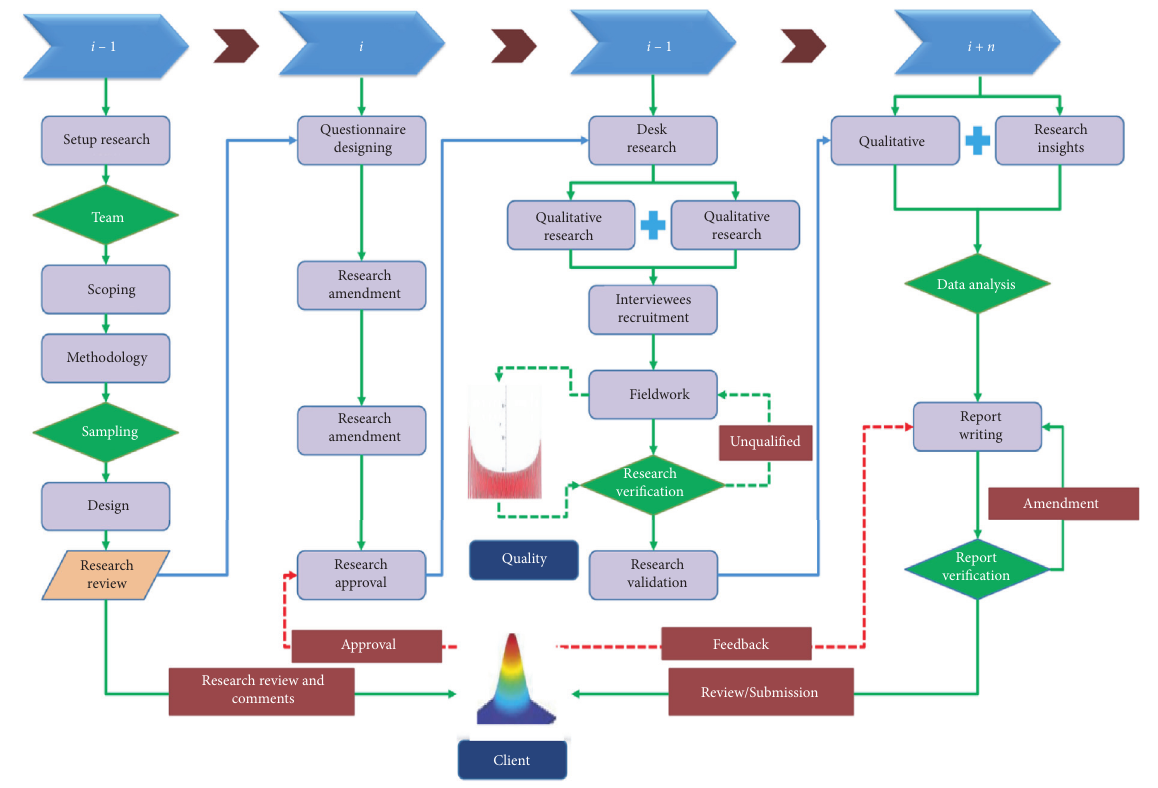
Figure 2: Partial heel matching trace